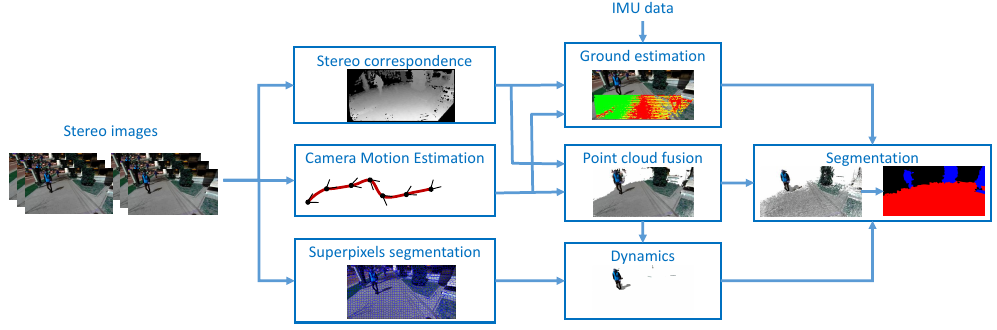
Figure 2. Overview of the computation steps in our stereo-based reconstruction and segmentation